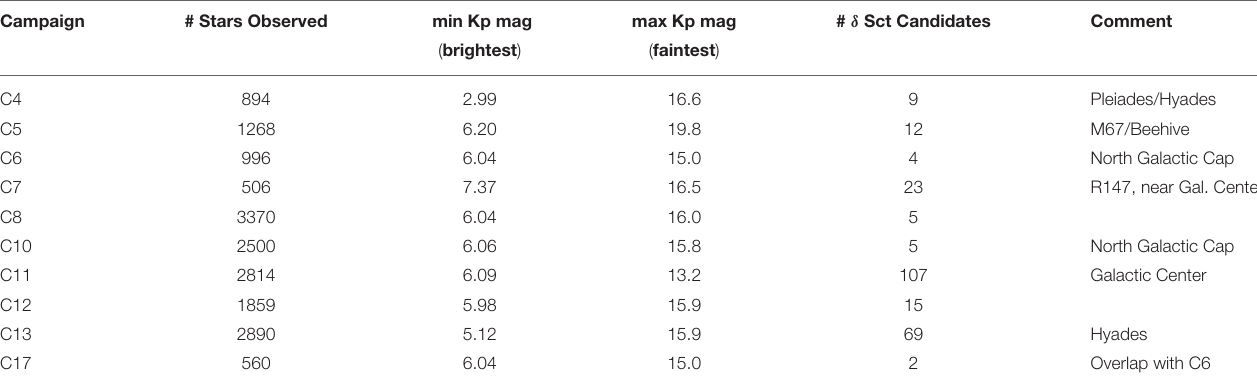
TABLE 1 | K2 Guest Observer survey results, with number of stars observed, minimum, and maximum Kepler magnitudes of stars observed in campaign, and number of identified δ Sct candidates.